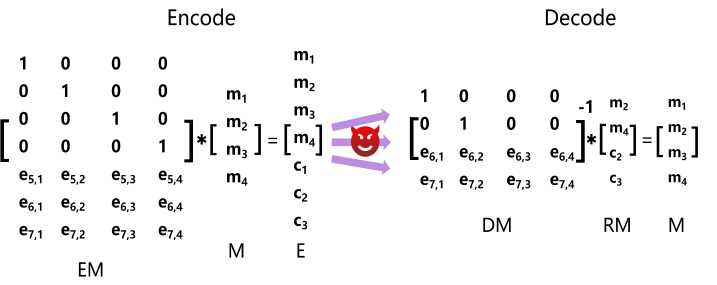
Figure 4. Transmission